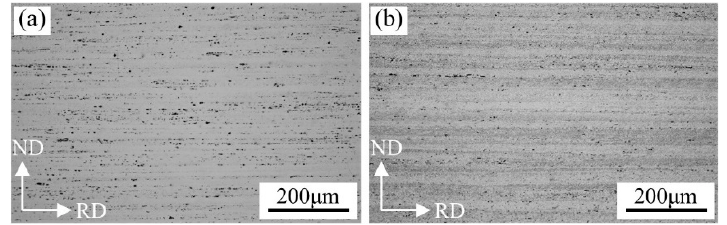
Figure 9. Metallographic structure of hot-rolled 6063 aluminum alloy. ( a ) VCR; ( b ) VHR.